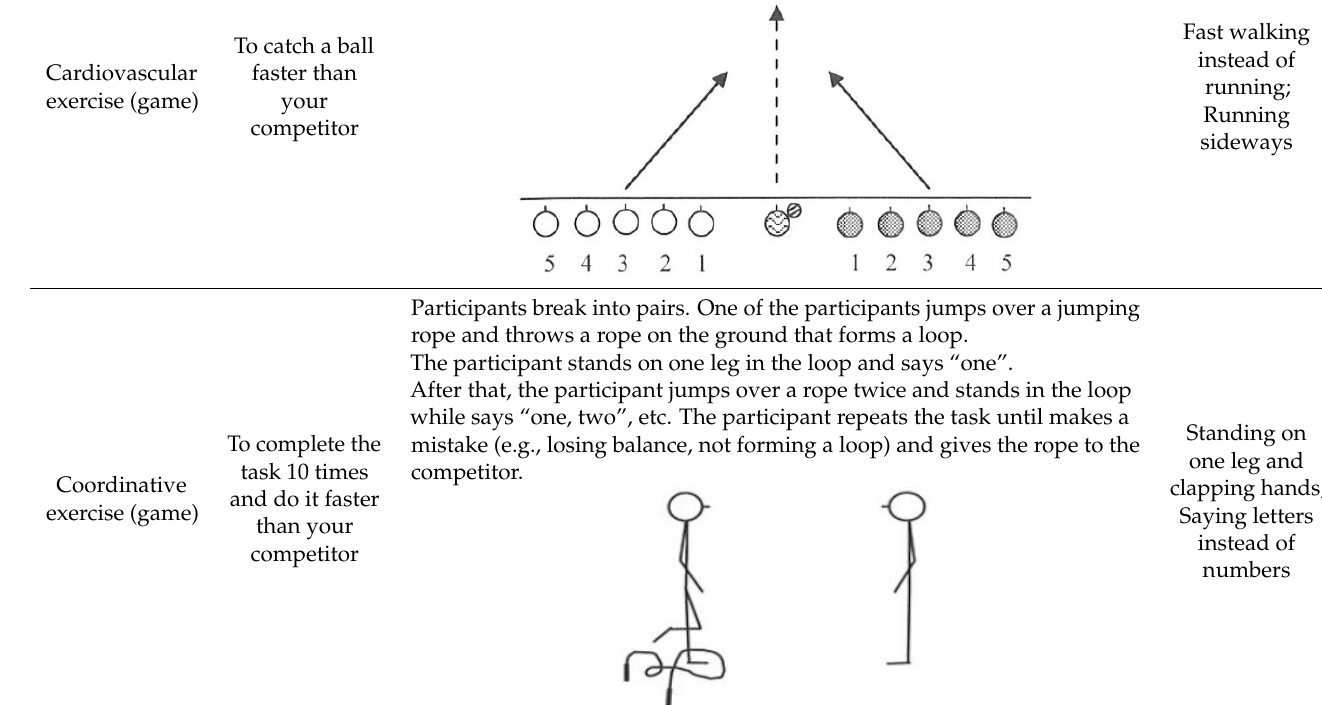
Table 2. Example of intervention exercises.